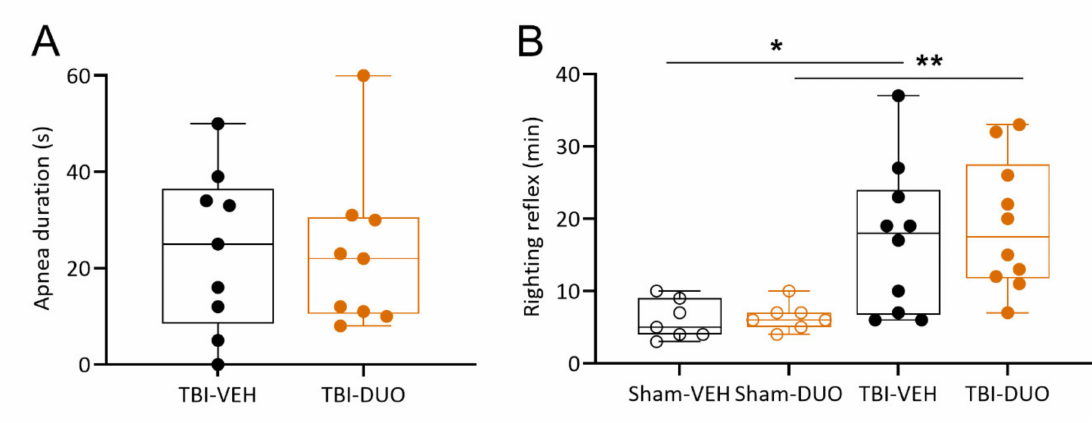
Figure 3. Apnea duration (s) and time to righting (min) in rats randomized to different treatment groups. ( A ) Apnea duration did not differ between rats with TBI randomized to either vehicle (TBI-VEH) or NAC+SFN duotherapy (TBI-DUO) ( p > 0.05, independent sample t-test). ( B ) Time to righting was longer in rats with TBI than in sham-operated experimental controls (TBI-VEH vs. Sham-VEH, p < 0.05; TBI-DUO vs. Sham-DUO, p < 0.01). No difference was detected between rats randomized to the TBI-VEH or TBI-DUO groups ( p > 0.05, independent sample t -test). Data are presented as whisker- plots with mean and minimum/maximum. Abbreviations: D, day; DUO, duotherapy treated with N-acetylcysteine and sulforaphane; NAC, N-acetylcysteine; SFN, sulforaphane; TBI, traumatic brain injury; VEH, vehicle. Statistical significances: * p < 0.05, between Sham-VEH and TBI-VEH groups (independent sample t-test), ** p < 0.01 between Sham-DUO and TBI-DUO groups (independent sample